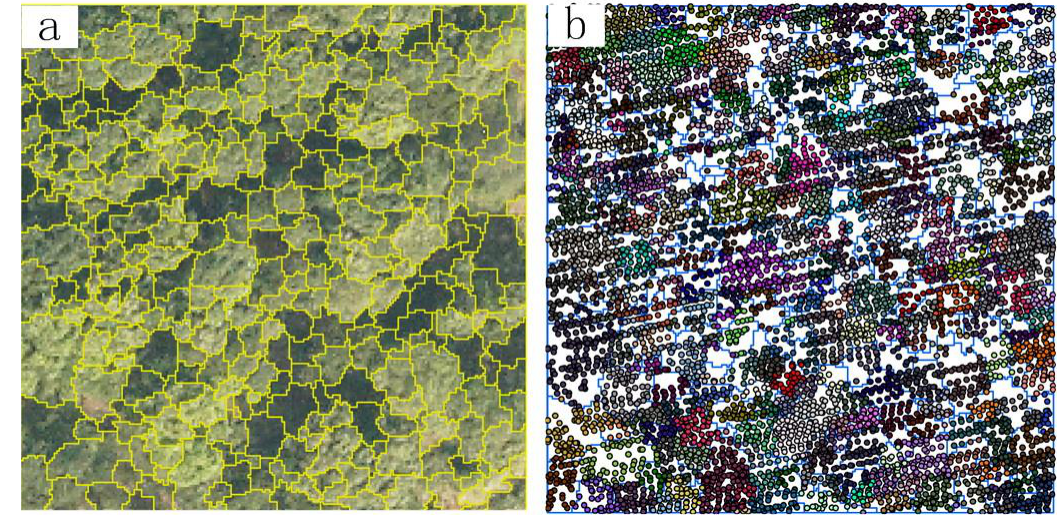
Figure 5. Multi-resolution segmentation in Plot No. 34: ( a ) segmented digital orthophoto map; ( b ) segmented point cloud.